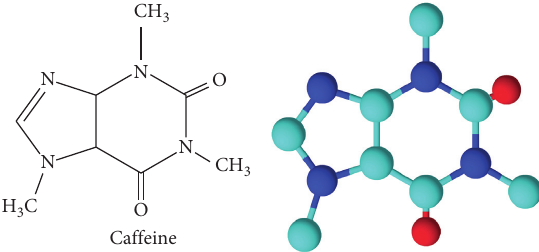
Figure 1: Chemical structure of